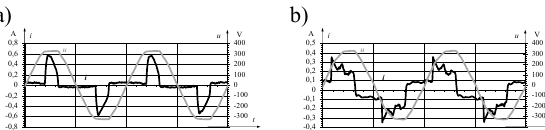
Fig.4. Phase angle between voltage and current for the first harmonic during the operation of the tested monitors.